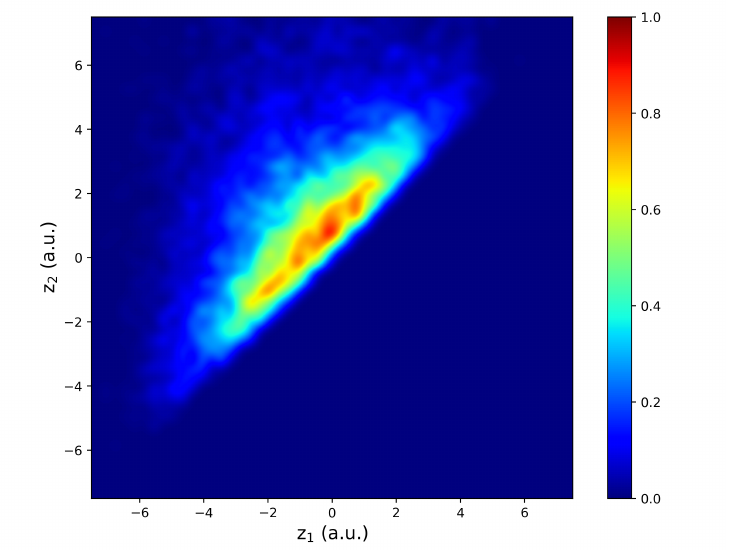
Figure 5. Normalized contour plot for the projectile z coordinate value at the moment in which the second electron is emitted (z 2 ) as a function of the z coordinate value at the moment in which the first electron is emitted (z 1